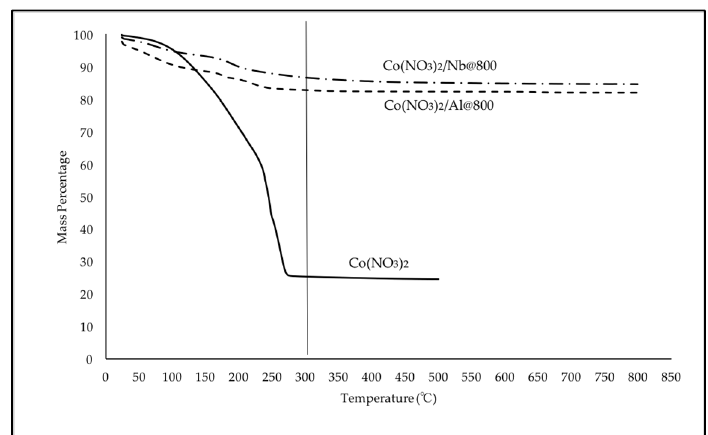
Figure 1. Thermal gravimetric analysis (TGA) tests for the decomposition of the Co(NO 3 ) 2 ·6H 2 O and impregnated catalysts Co(NO 3 ) 2 /Nb@800 and Co(NO 3 ) 2 /Al@800. Both Nb 2 O 5 and Al 2 O 3 were pre-